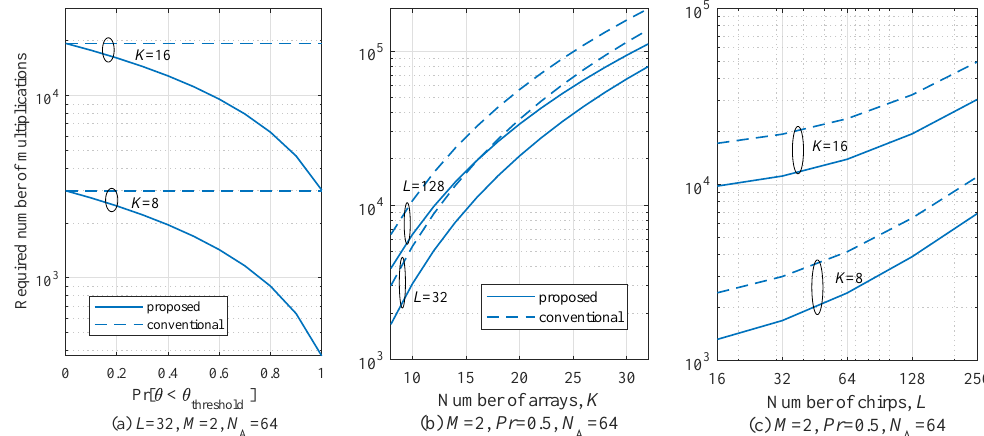
Figure 11. Comparison of complexity between conventional and proposed MUSIC algorithms for several parameters.